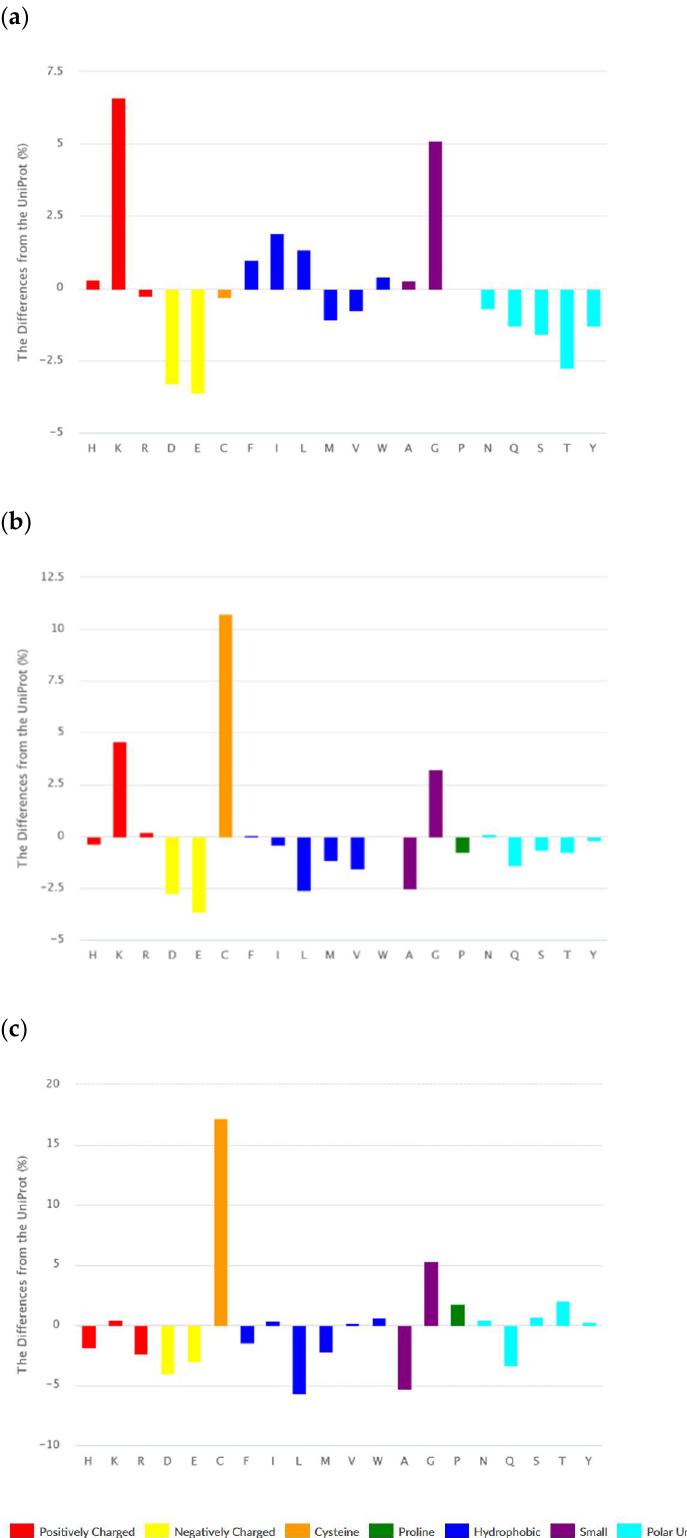
Figure 2. Amino acid composition of ( a ) linear; ( b ) disulfide-bonded, and ( c ) cyclic ribosomal peptides of DBAASP, presented as the difference from UniProt (https://dbaasp.org/statistics, accessed on 20 March 2021).